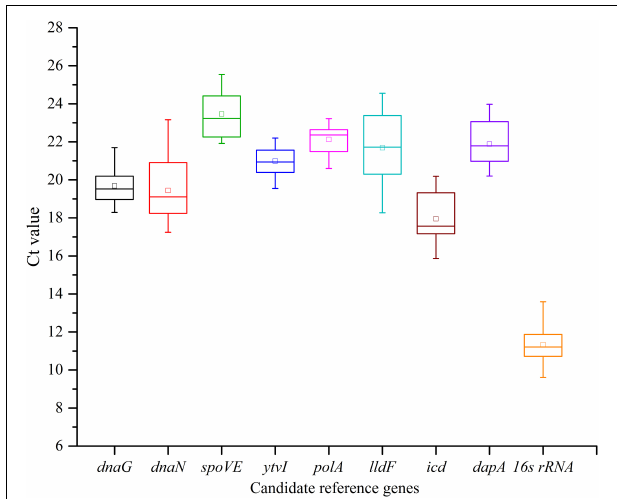
FIGURE 4 | Expression levels of nine candidate reference genes across all samples in Alicyclobacillus acidoterrestris . The outer box is determined from 25th to 75th percentiles, and the inner box represents the mean value. The line across the box is the median. The whiskers represent the minimum and maximum values.